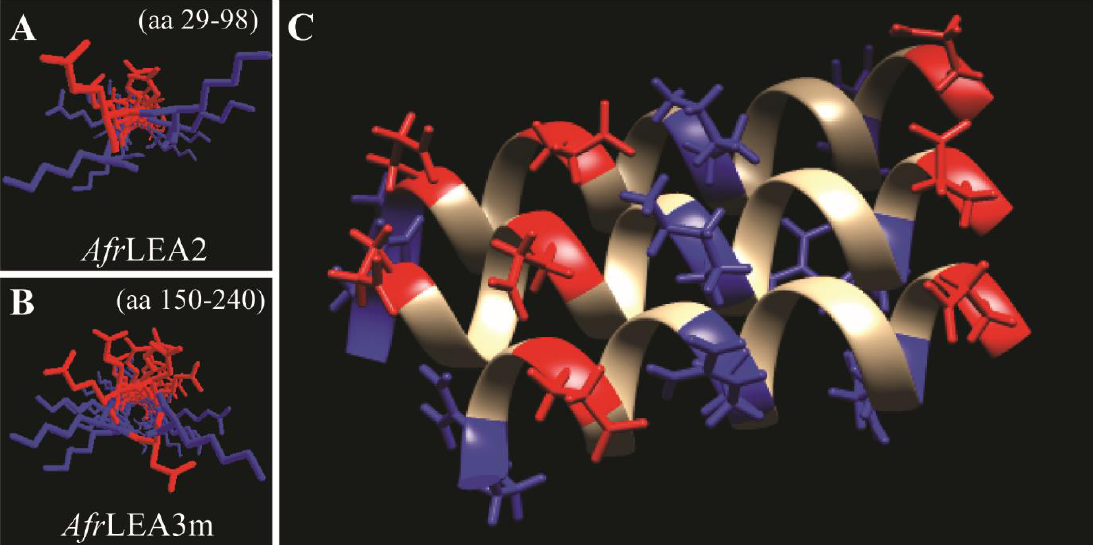
Figure 6. Three-dimensional structure and charge distribution of three LEA proteins from A. franciscana as predicted by I-Tasser. Colors represent the positive-charge residues in red and negative residues in blue. ( A ) Predicted α -helical regions of Afr LEA2 are shown to have characteristic positive-negative-positive residue stripes c.f. [38] . ( B ) Predicted α -helical regions of Afr LEA3m also showed characteristic positive-negative-positive residue stripes c.f. [38] . ( C ) Af LEA1 does not present the proposed charge pattern observed in Afr LEA2 and Afr LEA3m in its secondary structure. Still, its tertiary structure presents adjacent stripes of an alternating formal charge (positive-negative-positive-negative) on the protein surface.